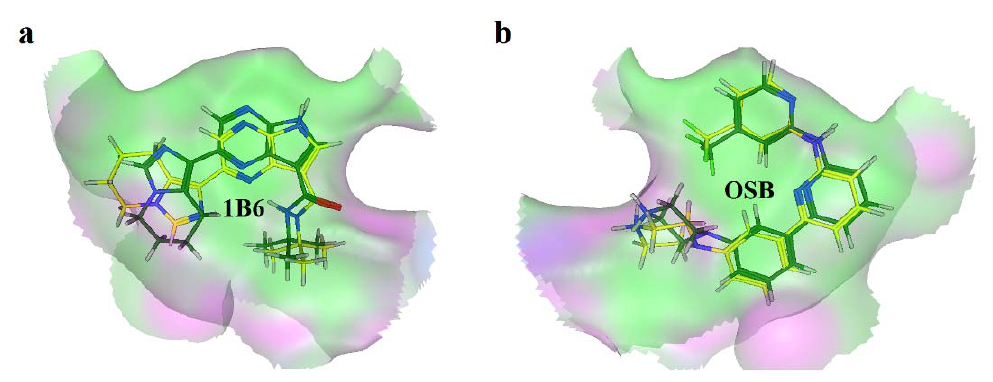
Figure 3. Superposition of conformations of docking results of 1B6 ( a ) and OSB ( b